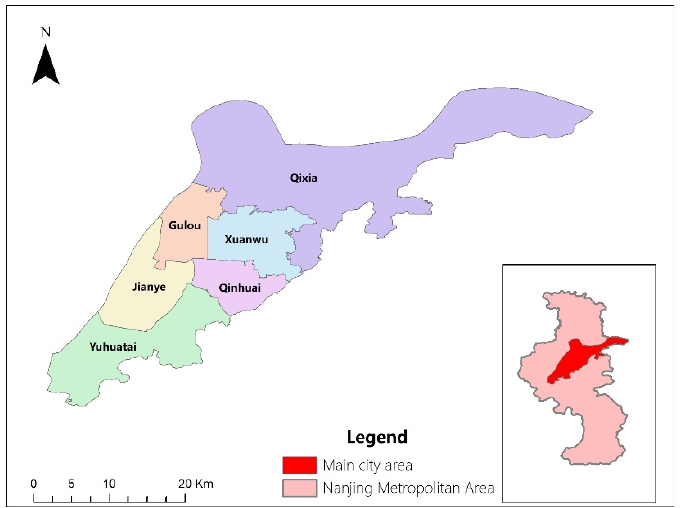
Figure 1. Location of study area in Nanjing and administrative zoning of main city area.